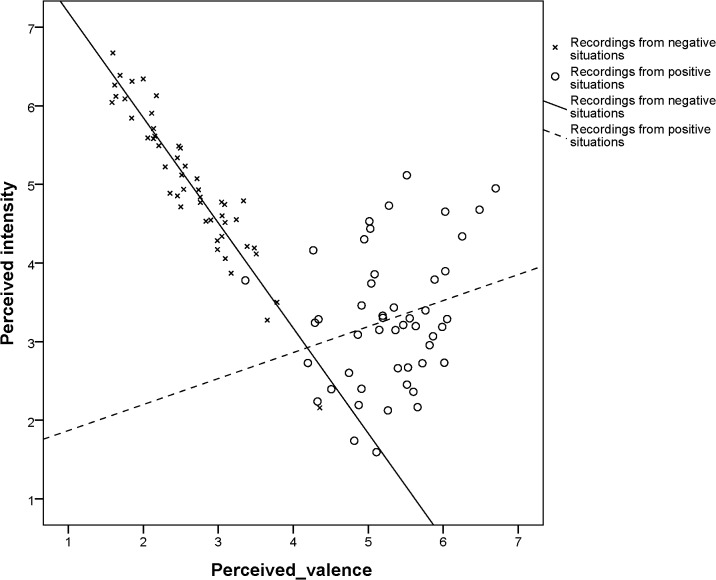
Perceived valence and intensity in infant recordings from positive and negative situations.
Note: Data points represent individual recordings and show average intensity and valence judgments by participants. Regression lines for recordings obtained in positive and negative situations shown.